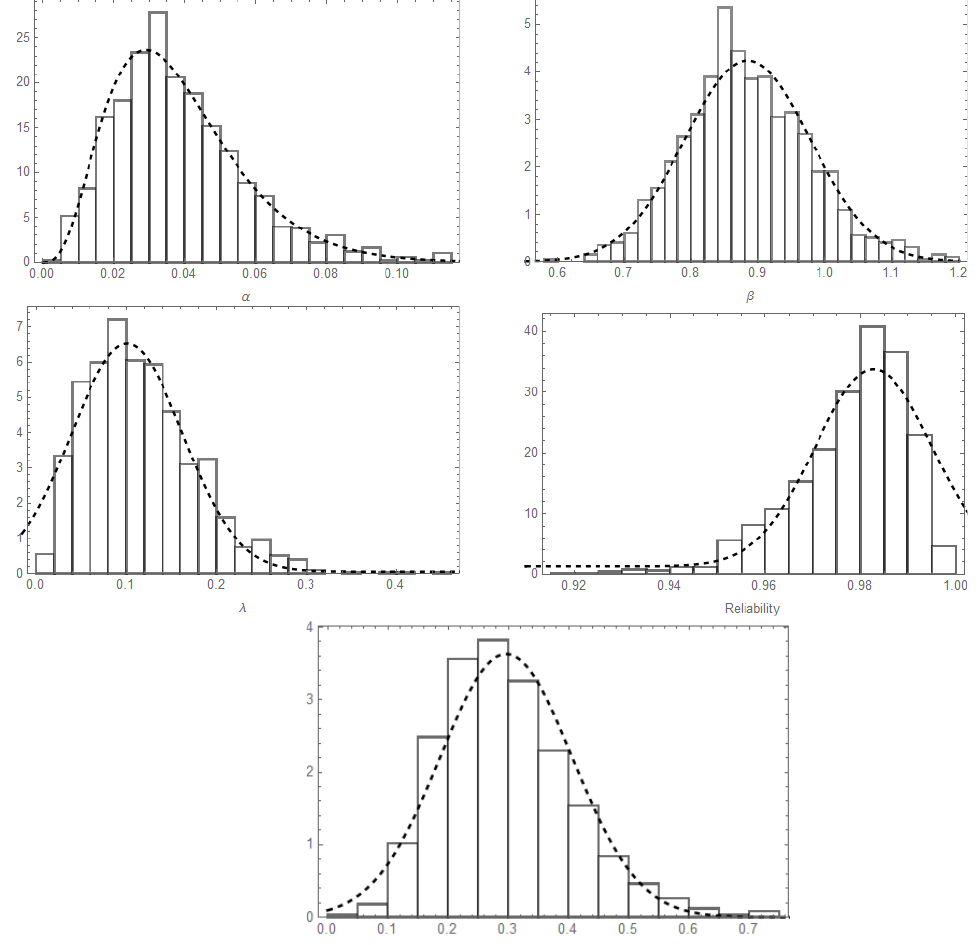
Figure 5. Histograms of the parameters obtained from MCMC